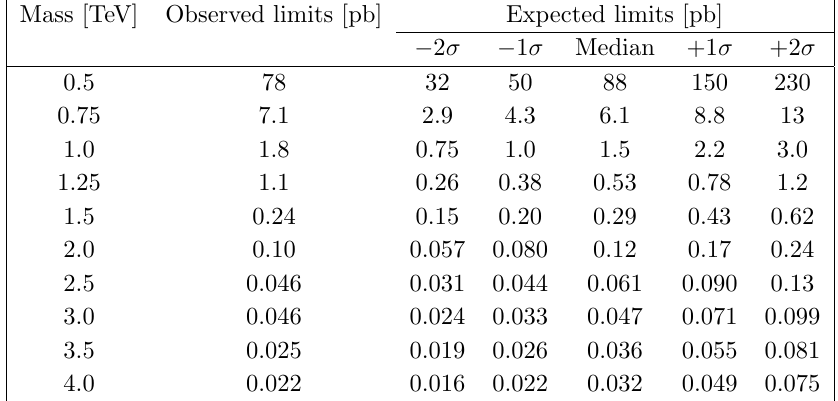
Table 6 . Expected and observed cross section limits at 95% CL, for the 1% width Z 0 resonance